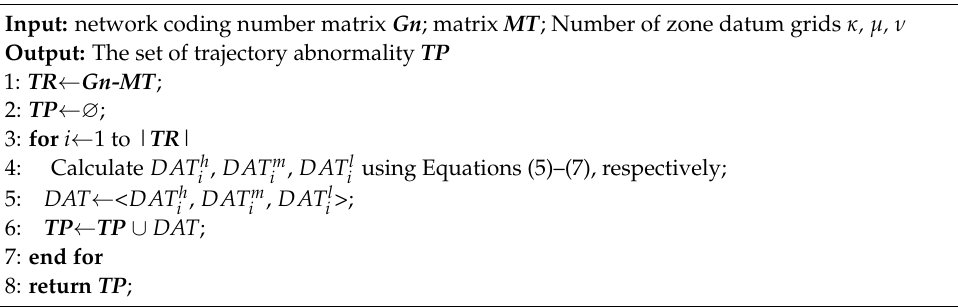
Algorithm 2: Trajectory abnormality degree